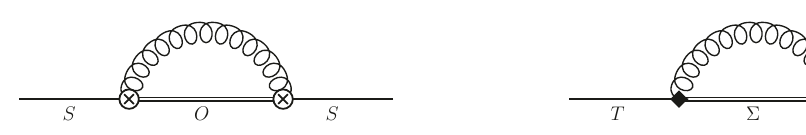
Figure 4 . The single continuous line stands for a singlet (antitriplet) propagator, the double line for an octet (sextet) propagator, the curly line for a chromoelectric correlator and the circle with a cross for a chromoelectric dipole vertex between singlet and octet (antitriplet and sextet)